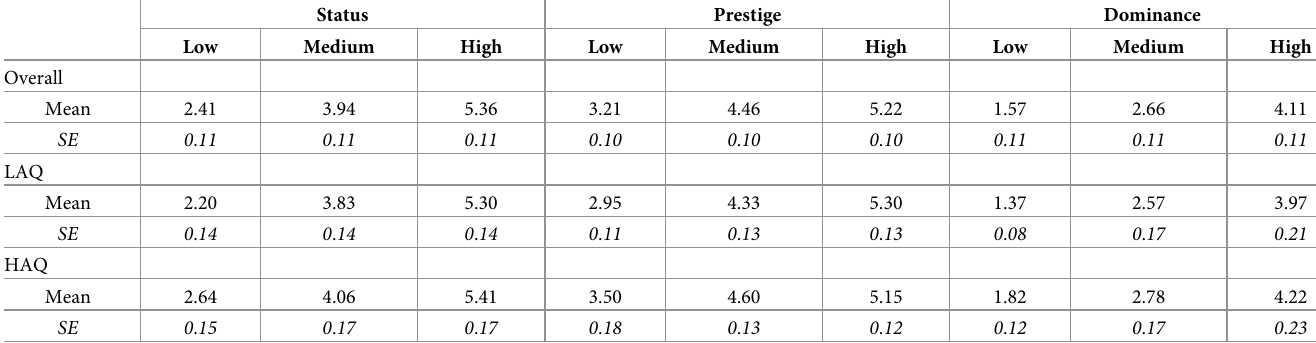
Table 1. LAQ and HAQ participants’ status-relevant ratings of